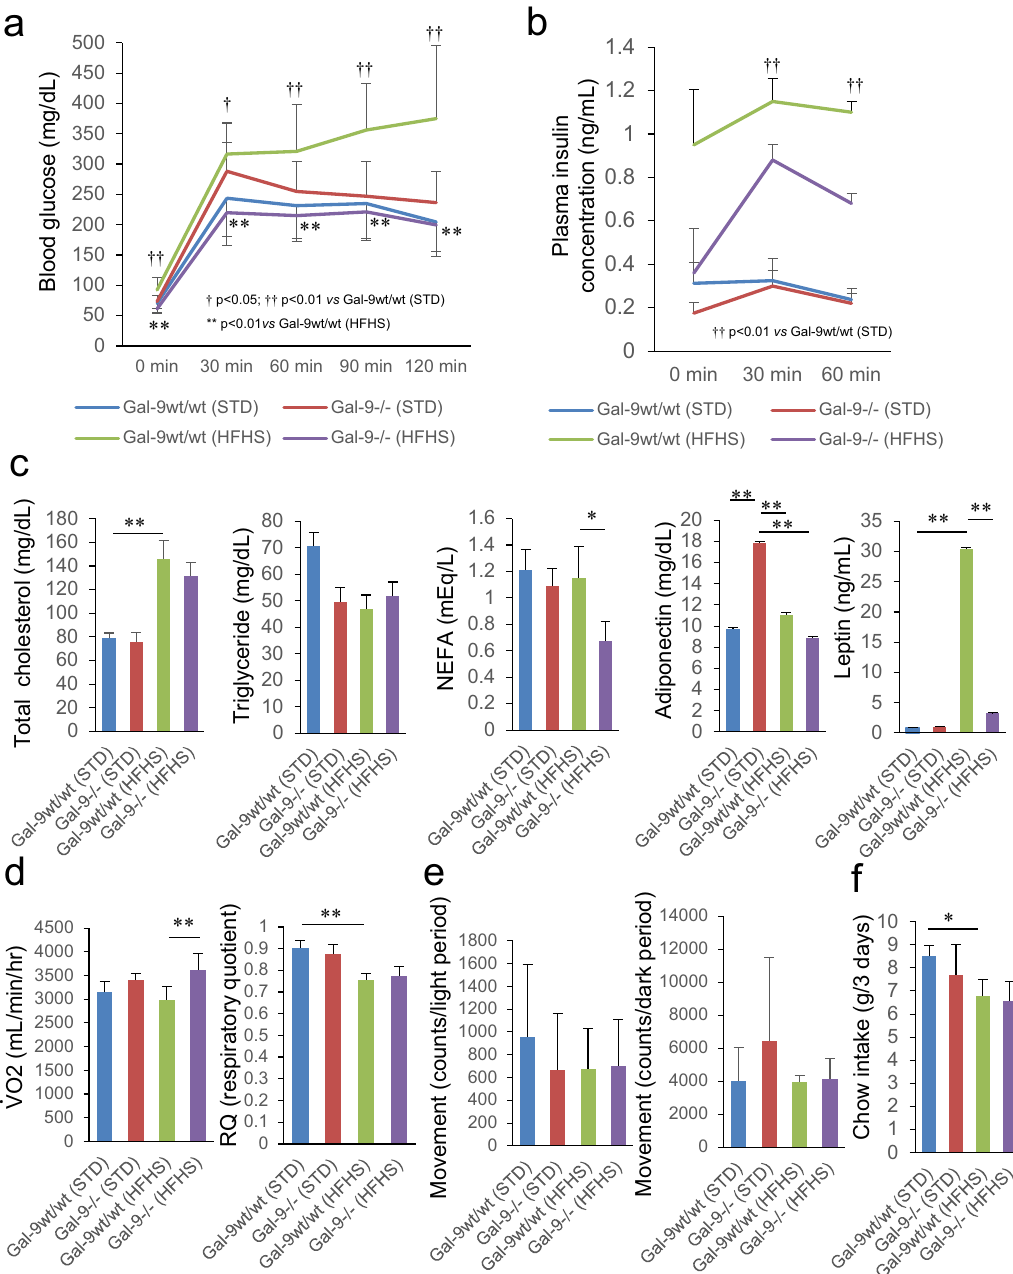
Figure 3. Glucose, lipid metabolism, and energy expenditures. ( a ) Blood glucose levels in intraperitoneal glucose tolerance tests (IPGTT; 1 mg/g weight) at 20–22 weeks of age. Gal-9 wt/wt (STD), n = 11; Gal-9 −/− (STD), n = 12, Gal-9 wt/wt (HFHS), n = 11; Gal-9 −/− (HFHS), n = 13. *, p < 0.05; **, p < 0.01 [Gal-9 wt/wt (HFHS) vs . Gal-9 −/− (HFHS)]; †, p < 0.05; ††, p < 0.01 [Gal-9 wt/wt (STD) vs . Gal-9 wt/wt (HFHS)]. One-way ANOVA with Tukey–Kramer. ( b ) Plasma insulin concentration in intraperitoneal glucose tolerance test. Gal-9 wt/wt (STD), n = 8; Gal-9 −/− (STD), n = 5, Gal-9 wt/wt (HFHS), n = 7; Gal-9 −/− (HFHS), n = 5. †, p < 0.05; ††, p < 0.01 [Gal-9 wt/wt (STD) vs . Gal-9 wt/wt (HFHS)]. Kruskal–Wallis test with Bonferroni correction. ( c ) Serum levels of cholesterol, triglyceride, non-esterified fatty acid (NEFA), adiponectin and leptin. Gal-9 wt/wt (STD), n = 4; Gal-9 −/− (STD), ˙ V n = 4, Gal-9 wt/wt (HFHS), n = 4; Gal-9 −/− (HFHS), n = 4. *, p < 0.05; **, p < 0.01. ( d ) Oxygen consumption rate ( wt/wt (STD), n = 3; Gal-9 −/− (STD), n = 6, Gal-9 wt/wt (HFHS), n = 4; Gal- ̇ O 2 ) and respiratory quotient (RQ). Gal-9 9 −/− (HFHS), n = 6. **, p < 0.01. ( e ) Locomotor activities during light and dark periods. Gal-9 wt/wt (STD), n = 3; Gal-9 −/− (STD), n = 4, Gal-9 wt/wt (HFHS), n = 4; Gal-9 −/− (HFHS), n = 5. ( f ) Chow intake. Gal-9 wt/wt (STD), n = 3; Gal-9 −/− (STD), n = 5, Gal-9 wt/wt (HFHS), n = 4; Gal-9 −/− (HFHS), n = 7. One-way ANOVA with